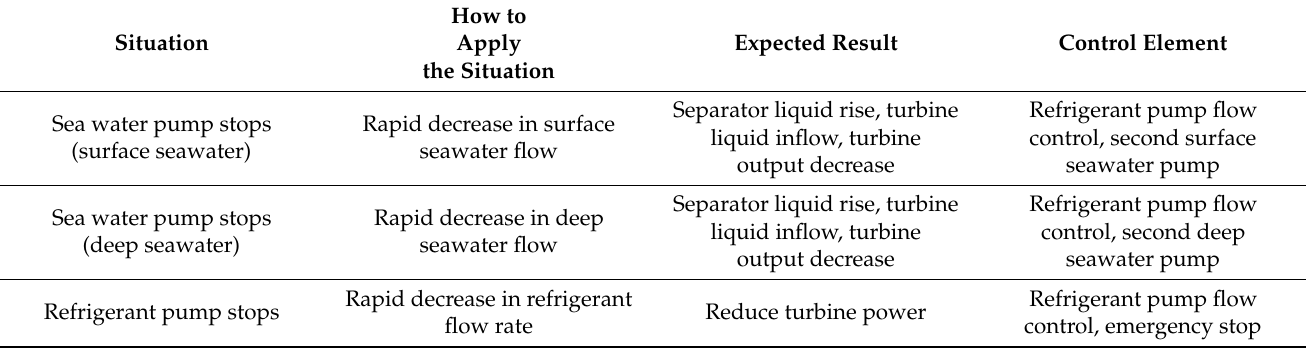
Table 3. Specifications of pump shut down